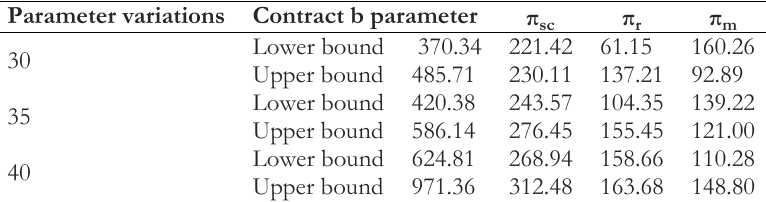
Fig. 10 also shows the variations trend in firms' profits due to wholesale price changes after signing the contract for the sample problem 1